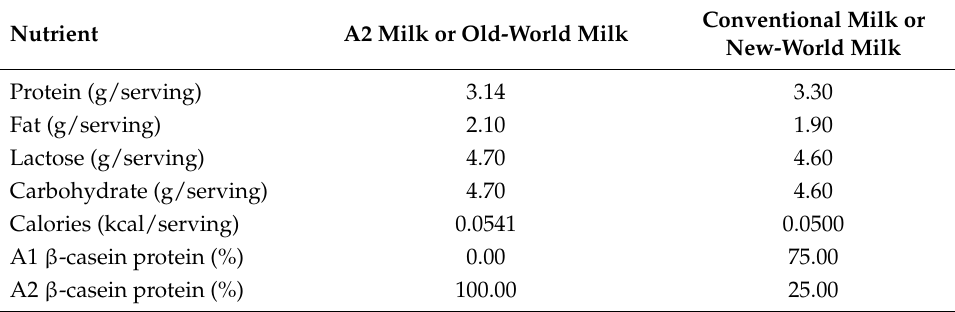
Table 2. Nutrient composition of the two milk